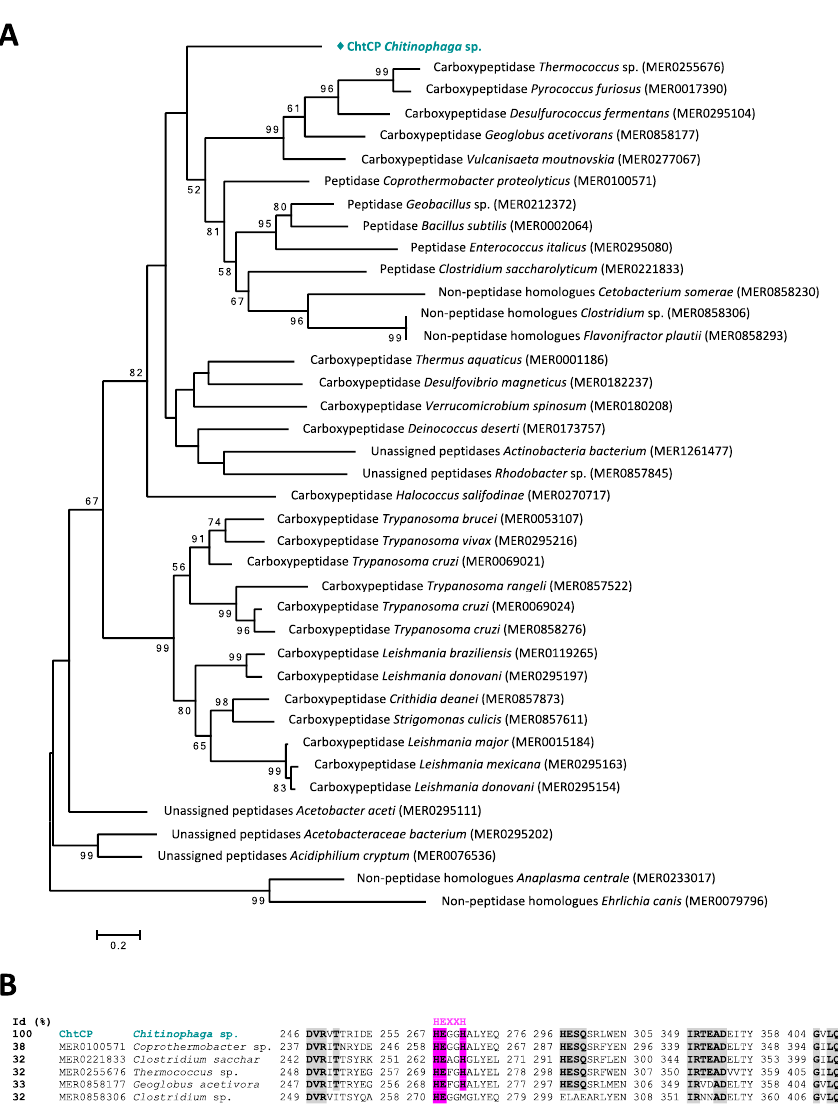
Figure 1. Sequence analysis of ChtCP. ( A ): Phylogenetic analysis by the Maximum Likelihood method. A total of 38 sequences of the M32 family were retrieved from the MEROPS database and together with ChtCP (in cyan), the evolutionary history was inferred by using the Maximum Likelihood method based on the JTT matrix-based model [51]. The tree with the highest log likelihood (-18173.3211) is shown here, and the percentage of trees in which the associated taxa clustered together is localized next to the branches. This tree is drawn to scale, with branch lengths measured in the number of substitutions per site. The sequence alignment was performed using ClustalW and the output file was used to perform the evolutionary analyses in MEGA7 [50]. The description of the sequence, microorganism of origin and MEROPS identity (between brackets) is shown for each sequence. ( B ): Sequence alignment of ChtCP and selected sequences from M32 family retrieved from the MEROPS database. The conserved motifs are highlighted in gray and the conserved motif of hyperthermophilic metallopeptidaes (HEXXH) in pink. The sequence alignment was built by using ClustalW and the sequence identity between ChtCP and other sequences is shown in the left hand side of the figure.